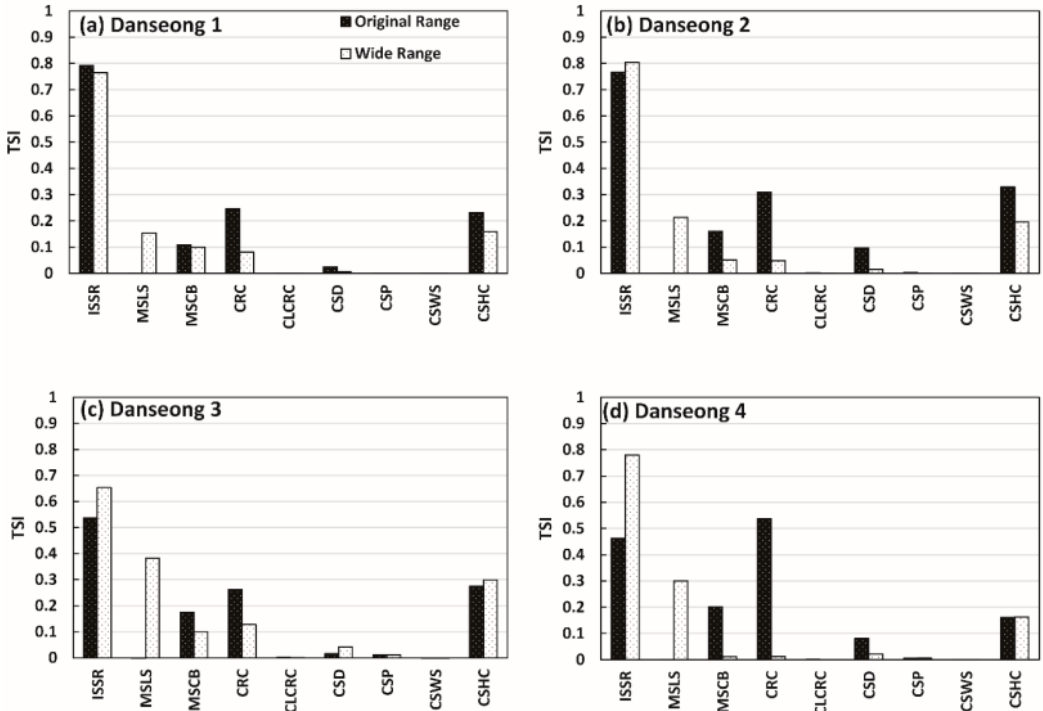
Figure 9. Sensitivity changes of parameters for different parameter ranges for the Danseong catchment (using NSE* objective function): ( a ) Danseong 1; ( b ) Danseong 2; ( c ) Danseong 3; ( d ) Danseong 4.